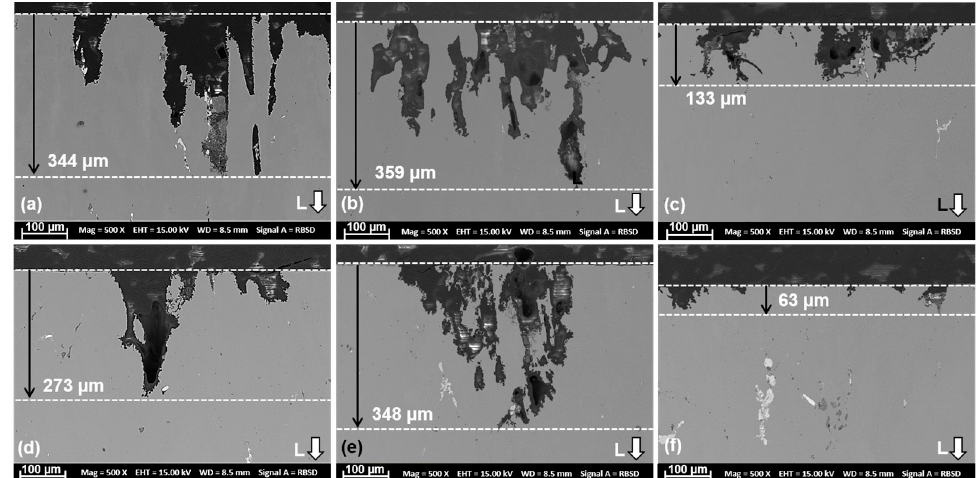
Figure 14. SEM images showing corrosion attack after the IGC test: ( a ) 7449-T4, ( b ) 7449-T6, ( c ) 7449-T76, ( d ) 7449+Cr-T4, ( e ) 7449+Cr-T6, ( f ) 7449+Cr-T76.